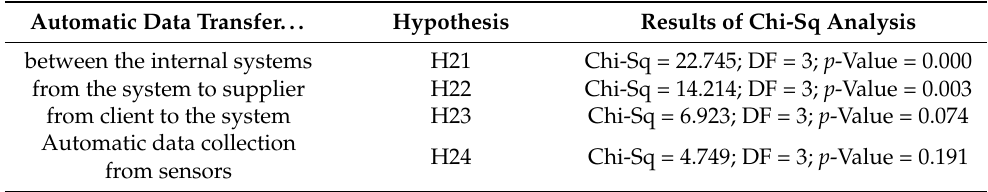
Table 7. Results of Chi-Sq analysis for data transfers depending on number of machines. Automatic Data Transfer...